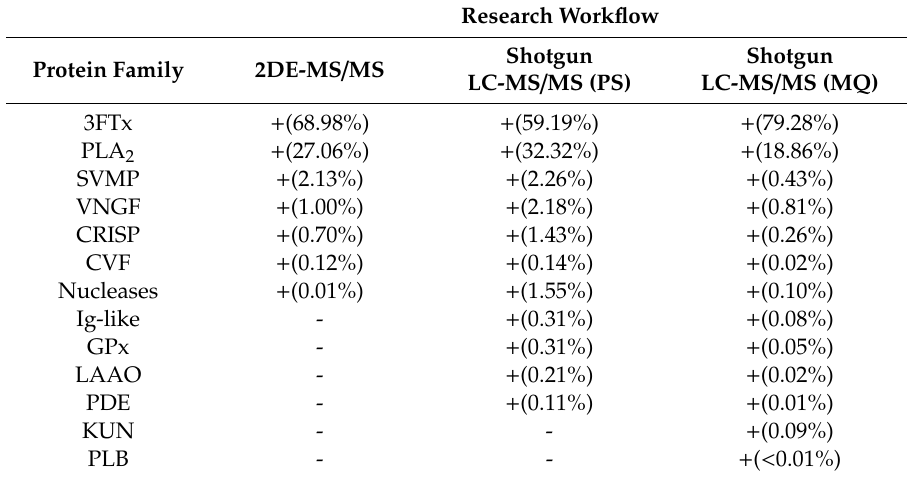
Figure 1. The comparison of the number of proteins identified using di ff erent research workflows. Shotgun LC-MS / MS strategy yielded in the identification of 37 and 39 proteins for PeptideShaker (PS) and MaxQuant (MQ) approaches, respectively. Both software provided a relatively high share of workflow-specific proteins. Previous 2DE-MS / MS analysis allowed for the detection of 19 proteins. Table 1. Protein families detected in Naja ashei venom using di ff erent research workflows. The values in brackets represent the percentage share of a given group in the proteome, determined using workflow-specific quantitative